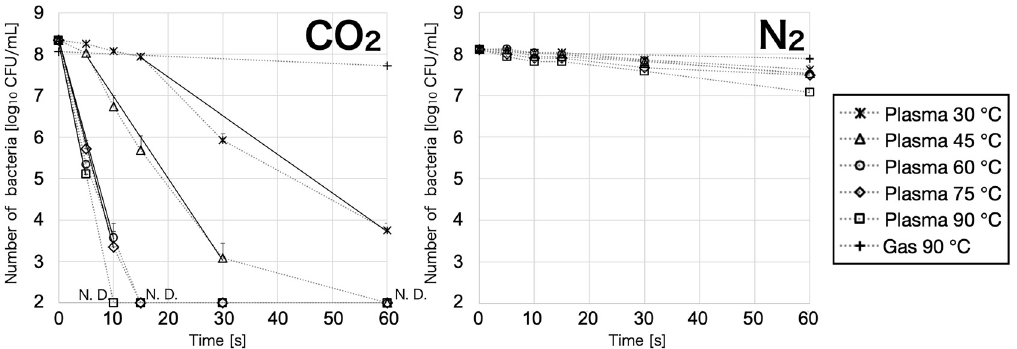
Figure 3. Relationship between the gas temperature and bactericidal effect of carbon dioxide and nitrogen plasma. In the left graph of the carbon dioxide treatment result, the solid black line shows the result used to calculate the BA value. The slope represents the BA value.